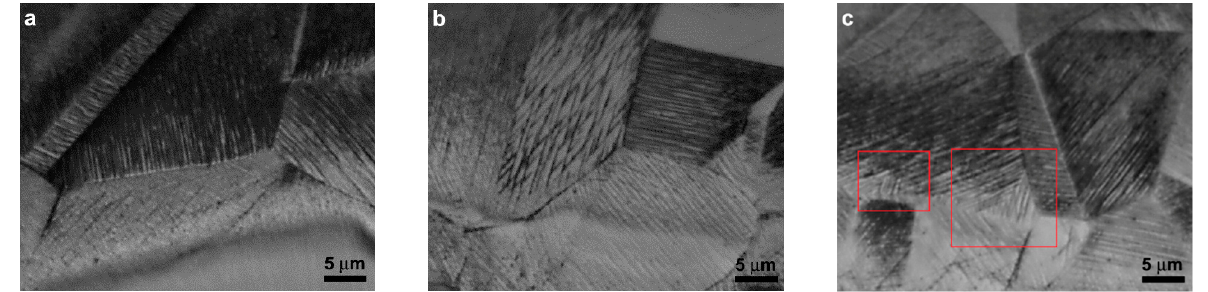
Figure 7. Details (parallel slip lines ( a ), crossing slip lines ( b ), slip lines changing their orientation ( c )) of the microstructure of the outer modified surface layer of a sample nitrided at 380 °C, 3 h, 50 vol.% N 2 + 50 vol.% H 2 . The red lined boxes in ( c ) evidence the change in orientation of the slip lines. (Tapered section: the markers refer to the length in the tapered section; etchant: acetic glyceregia).